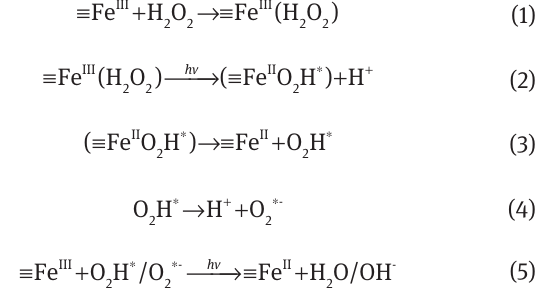
Figure 2: Dynamic curves of MO degradation over bare β -FeOOH and CNTs/ β -FeOOH composites with different weight additions of CNTs under VL irradiation; (A) 18.8%CNTs/ β -FeOOH + tert-butyl alcohol; (B) β -FeOOH; (C) 9.4%CNTs/ β -FeOOH-mixing; (D) 18.8%CNTs/ β -FeOOH O ; (E) 0.94%CNTs/ β -FeOOH; (F) 4.7%CNTs/ β -FeOOH; without H 2 2 (G) 9.4%CNTs/ β -FeOOH; (H) 18.8%CNTs/ β -FeOOH. Test conditions: